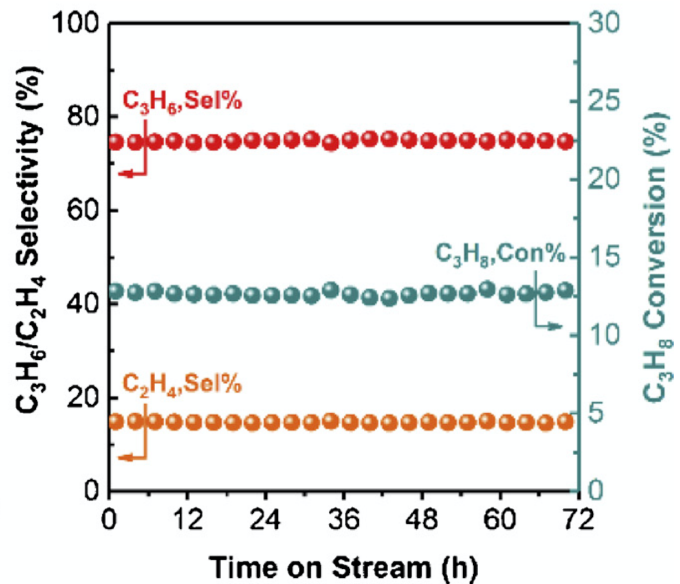
Figure 7. Stability test of g-C 3 N 4 -12 h at 500 ◦ C in PDH process. Reaction conditions: 0.7 g catalyst, He/C 3 N 8 /O 2 = 4/4/1, flow rate = 18 mL/min. (Reprinted with permission from [44]. Copyright 2020